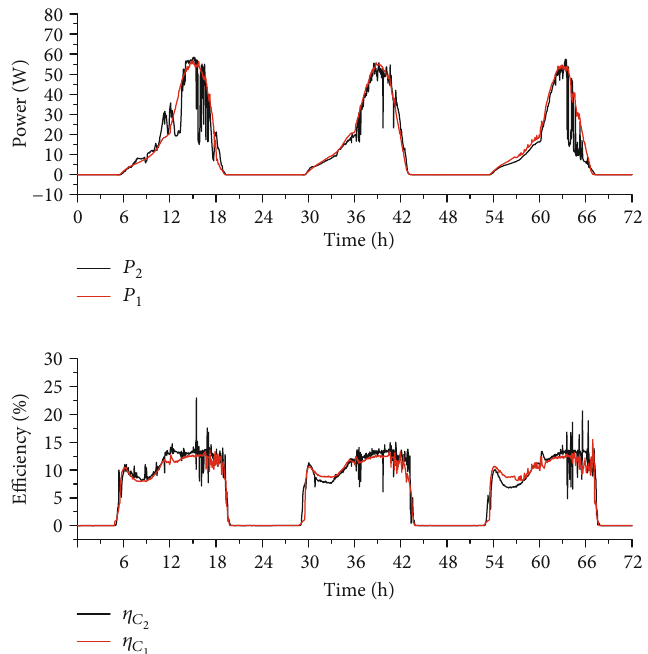
Figure 5: Electric power and e ffi ciency of photovoltaic cells.